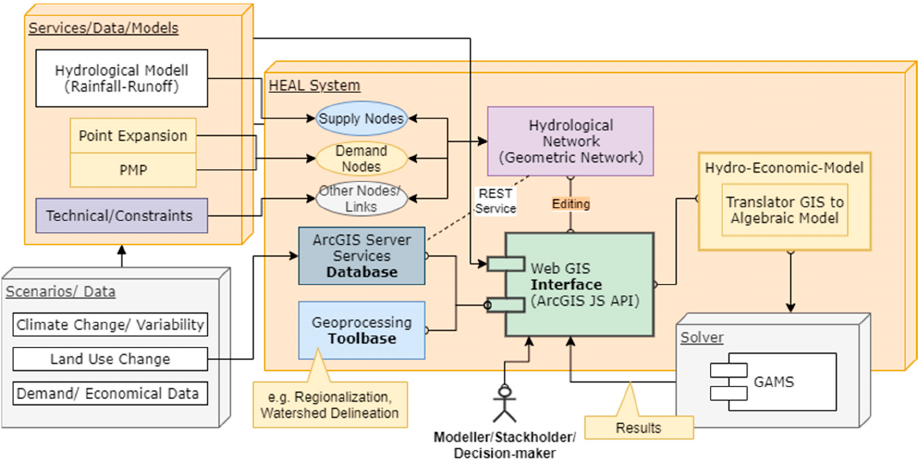
Figure 1. Flow chart GIS, DSS and Hydro-Economic-Model Integration using the HEAL System.